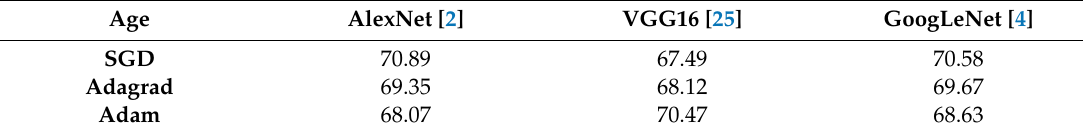
Table 9. Gender classification results of the Morph database by the three CNNs.